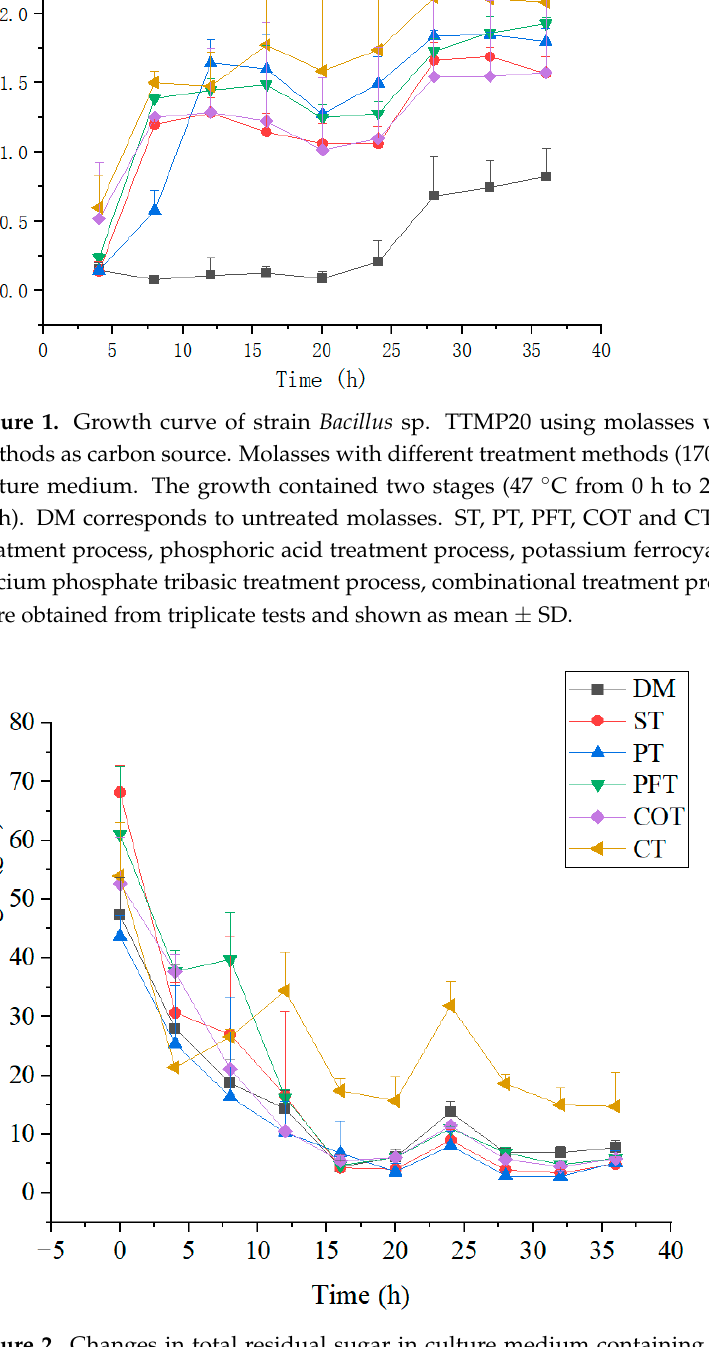
Figure 2. Changes in total residual sugar in culture medium containing molasses with different treatment methods. Molasses with different treatment methods (170 mL/L) was added into culture medium. DM represents untreated molasses. ST, PT, PFT, COT and CT represent sulfuric acid treatment process, phosphoric acid treatment process, potassium ferrocyanide treatment process, calcium phosphate tribasic treatment process, combinational treatment process, respectively. Data were obtained from triplicate tests and shown as mean ± SD.